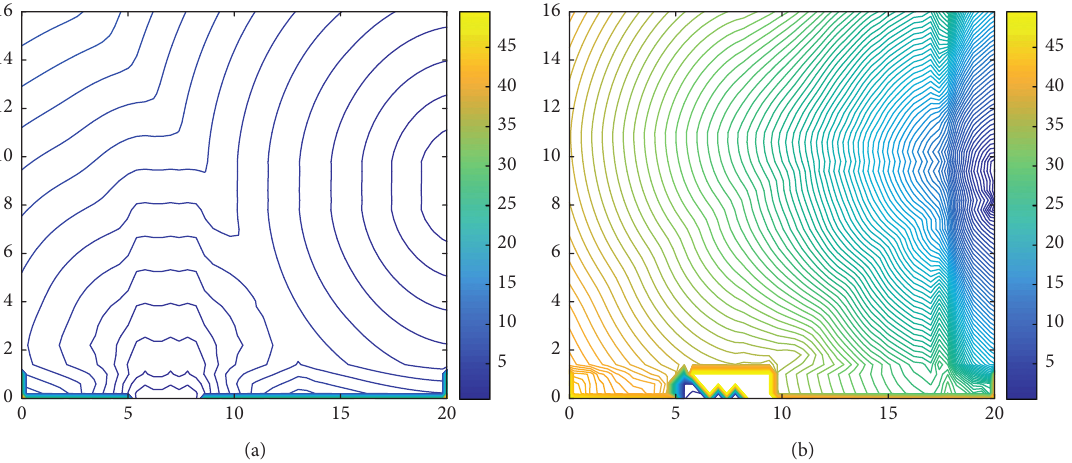
Figure 8: Contour plots of the dynamic potential (estimated remaining travel time) of 300 pedestrians in scenario ( ii ) and scenario ( i ) at t � 15 . 08 s. (a) scenario (i) and (b) scenario Table 1. Large crowds are formed around Exit 2, and pedestrians take long time to move out of the room in scenario ( ii ) .